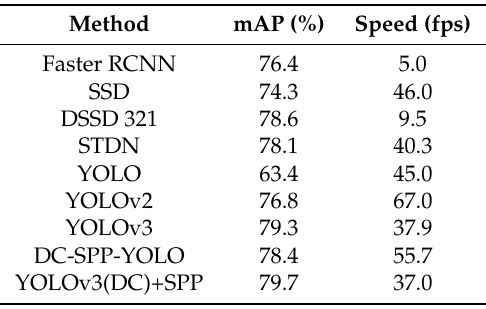
Table 2. mAP and speed